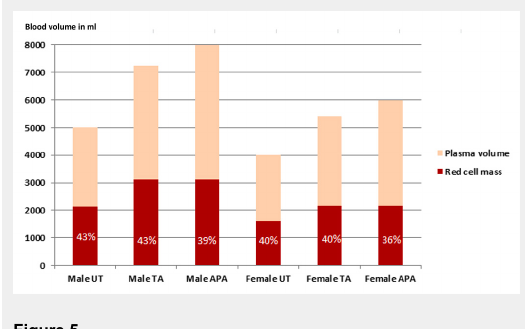
Total blood volume of male and female untrained, top athletes and athletes with dilutional pseudoanaemia in ml [44, 46, 49]. APA = athlete with dilutional pseudoanaemia; TA = top athlete; UT = untrained In the column of the red cell mass the haematocrit in percentage is shown in white letters.